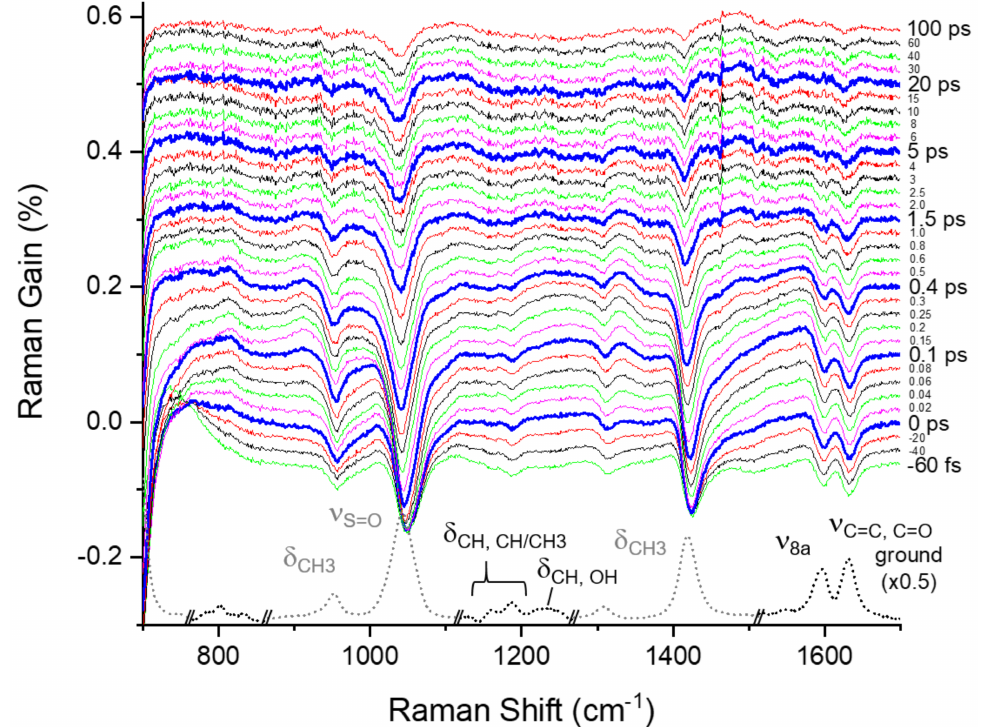
Figure 3. Femtosecond stimulated Raman spectra of curcumin in DMSO obtained with 403 nm excitation. The ground state spectrum taken at − 5 ps was subtracted from each spectrum to show the temporal changes clearly. The intensities of the solvent vibrational bands including ν S=O at 1043 cm − 1 and δ CH3 at 952, 1307, and 1419 cm − 1 were further rescaled ( × 0.2) in the ground